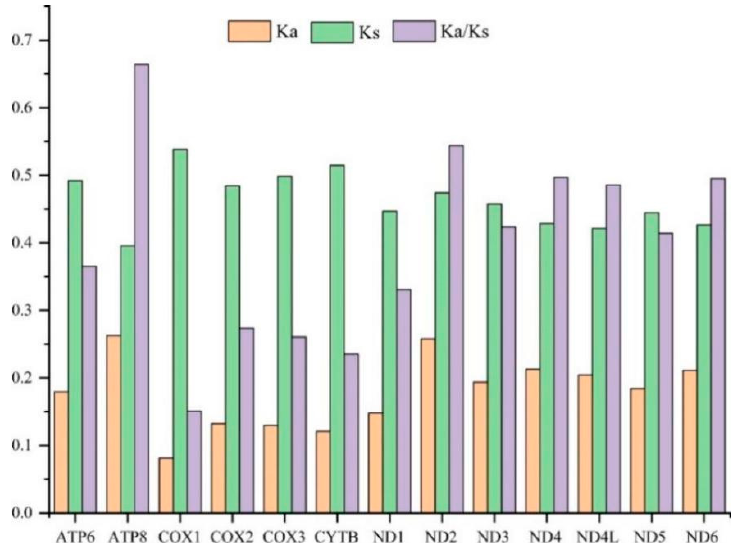
Figure 3. The evolutionary rate of each PCG in the mitogenomes of 32 Cicadellidae species in this study. Ka is the nonsynonymous nucleotide substitutions per nonsynonymous site, Ks is the synonymous nucleotide substitutions per synonymous site, and Ka/Ks is the ratio of the rate of nonsynonymous substitutions to the rate of synonymous substitutions.